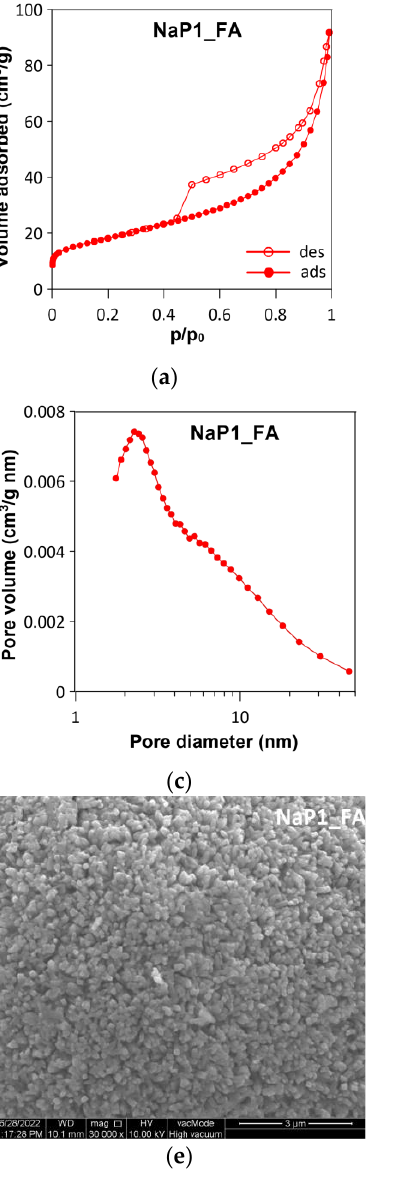
Figure 3. Textural analysis of NaP1_FA and NaP1_C samples: ( a , b ) N 2 adsorption/desorption isotherms, ( c , d ) pore size distribution diagrams, and ( e , f ) SEM microphotographs. The BJH pore size distribution of NaP1_FA showed a domination of 2 – 3-nm pores, with an average pore diameter of approximately 8.7 nm. The P1-C pore size distribution showed a dominance of pores on the border between micropore and mesopore sizes. The average pore diameter was approximately 7.8 nm (Table 2). Table 2. The textural parameters of obtained zeolitic materials.